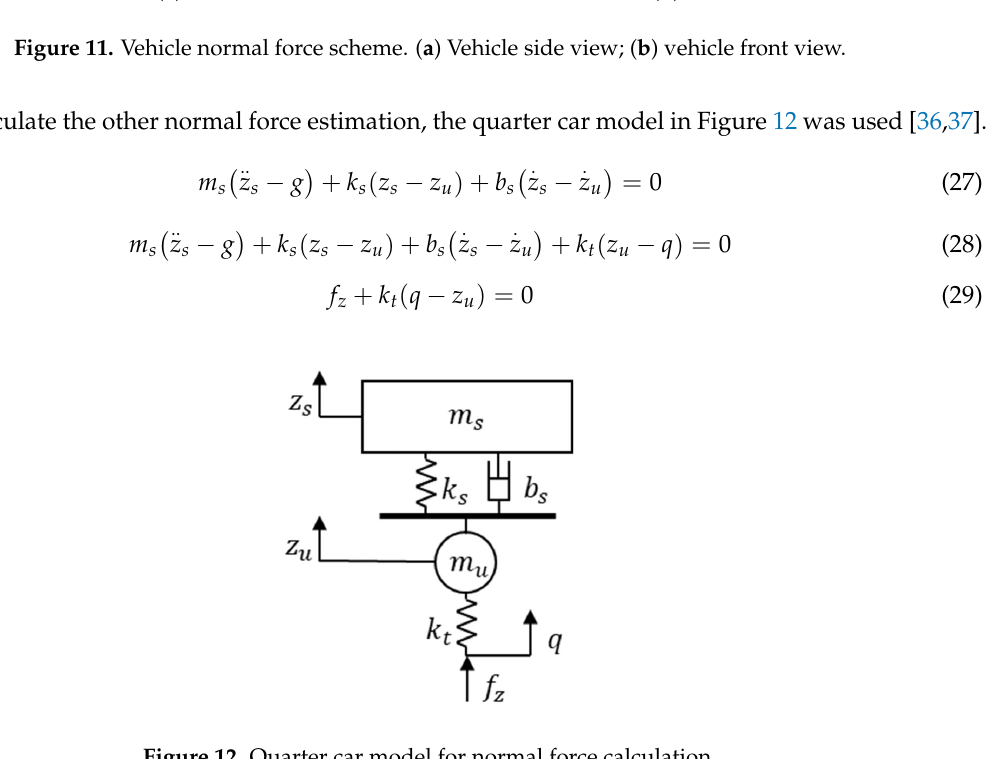
Figure 12. Quarter car model for normal force calculation. 𝑚 (cid:3046) (𝑧̈ (cid:3046) − 𝑔) + 𝑘 (cid:3046) (𝑧 (cid:3046) − 𝑧 (cid:3048) ) + 𝑏 (cid:3046) (𝑧̇ (cid:3046) − 𝑧̇ (cid:3048) ) = 0